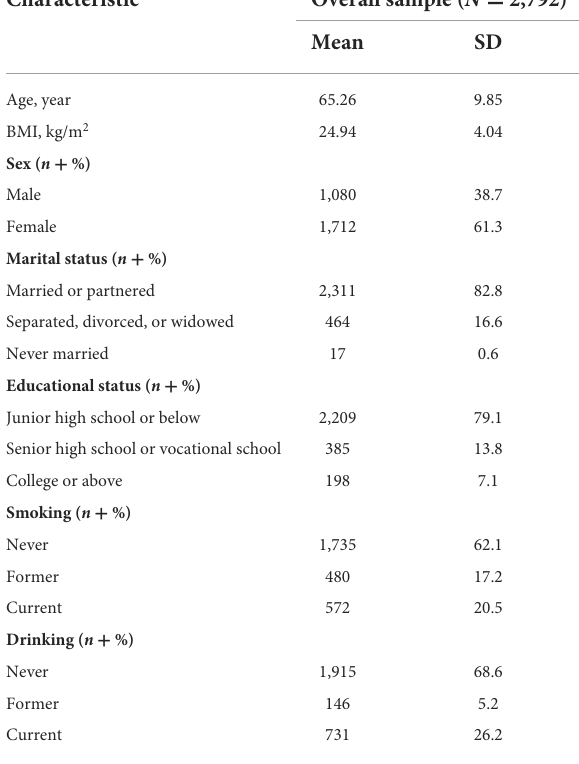
TABLE 1 Basic characteristics of